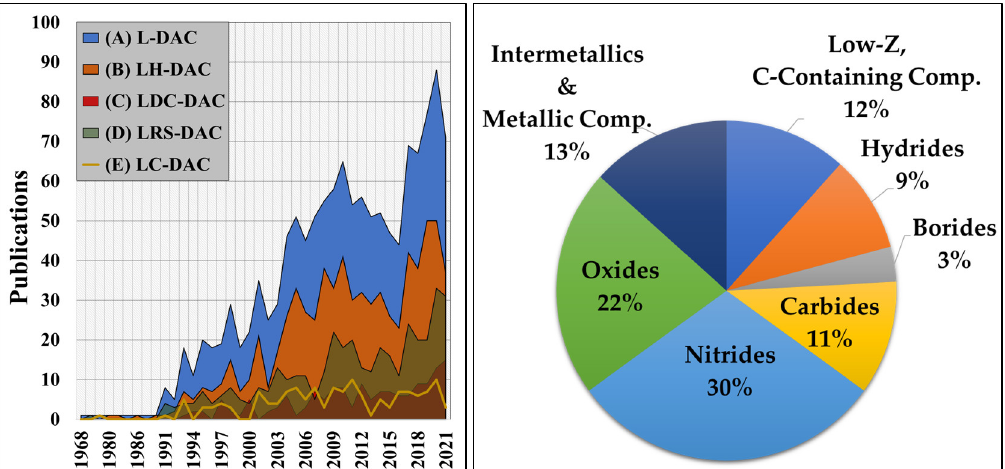
Figure 2. At left, ( A ) the total annual scientific production for laser- and synchrotron-based studies, ( B ) all L-DAC studies with (just) UV-IR lasers, ( C ) laser-heated diamond anvil cell (LH-DAC) research papers where primarily laser heating has been conducted for materials modification, ( D ) LRS-DAC articles where laser-induced chemical reactions/synthesis occurred, and ( E ) LC-DAC spectroscopic studies, [data for ( A – E ) obtained from the Web of Science database [26]. At right, the proportion of LRS-DAC-synthesised materials organised by the material categories: low-Z carbon-containing compounds, metal -hydrides, -borides, -carbides, -nitrides, -oxides, and high-Z metallic compounds and intermetallics.